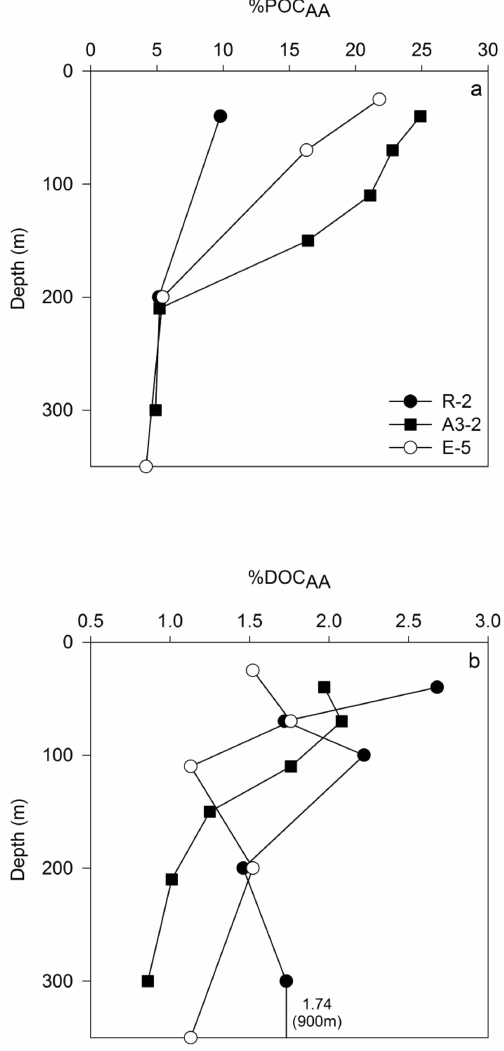
Figure 2. Proportion of (a) particulate and (b) dissolved organic carbon quantified as amino acids (%POC AA and %DOC AA ) for three representative stations (R-2, A3-2, E-5) at 0–350m depth. The value close to the station R-2 profile is the next data point at